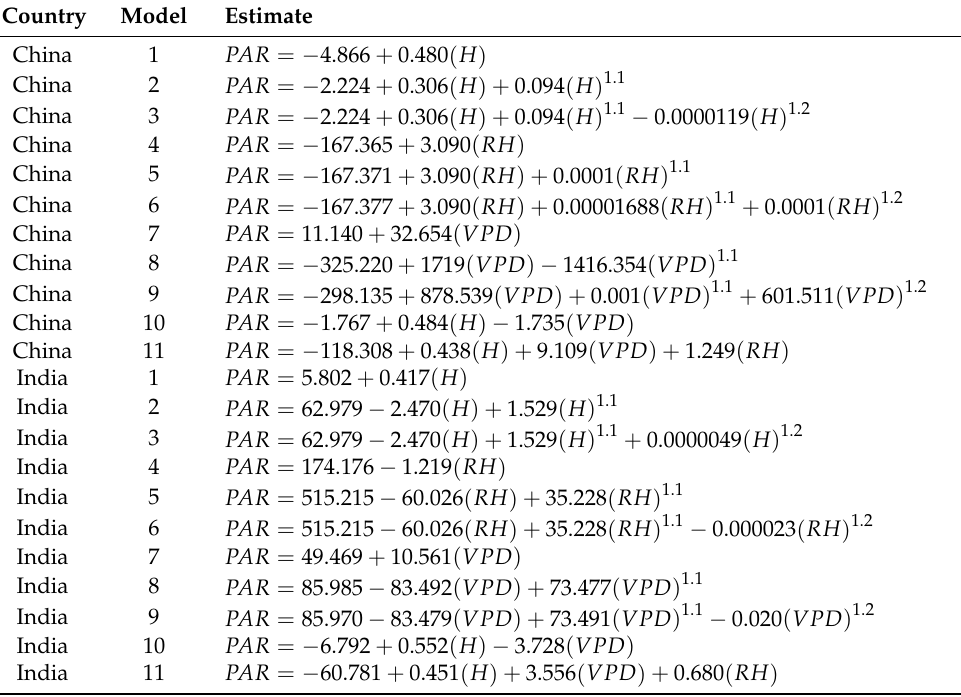
Table 5. Fitted CARIMA models for predicting PAR productivity in China and